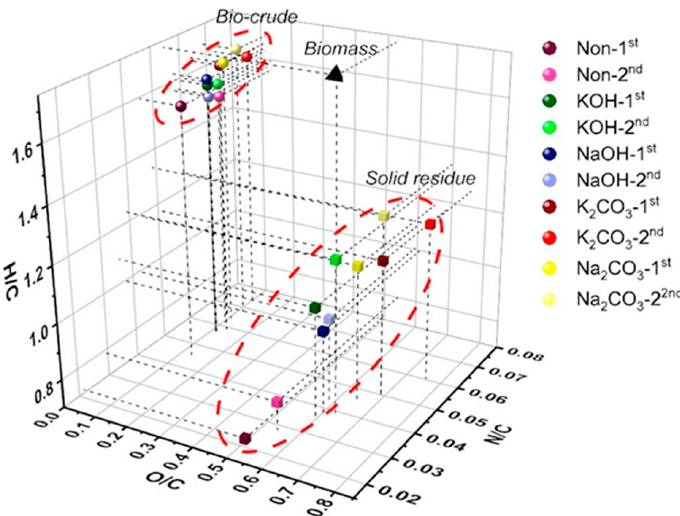
Figure 4. Van Krevelen 3D scatter plot of bio-crude, solid residue, and biomass samples.